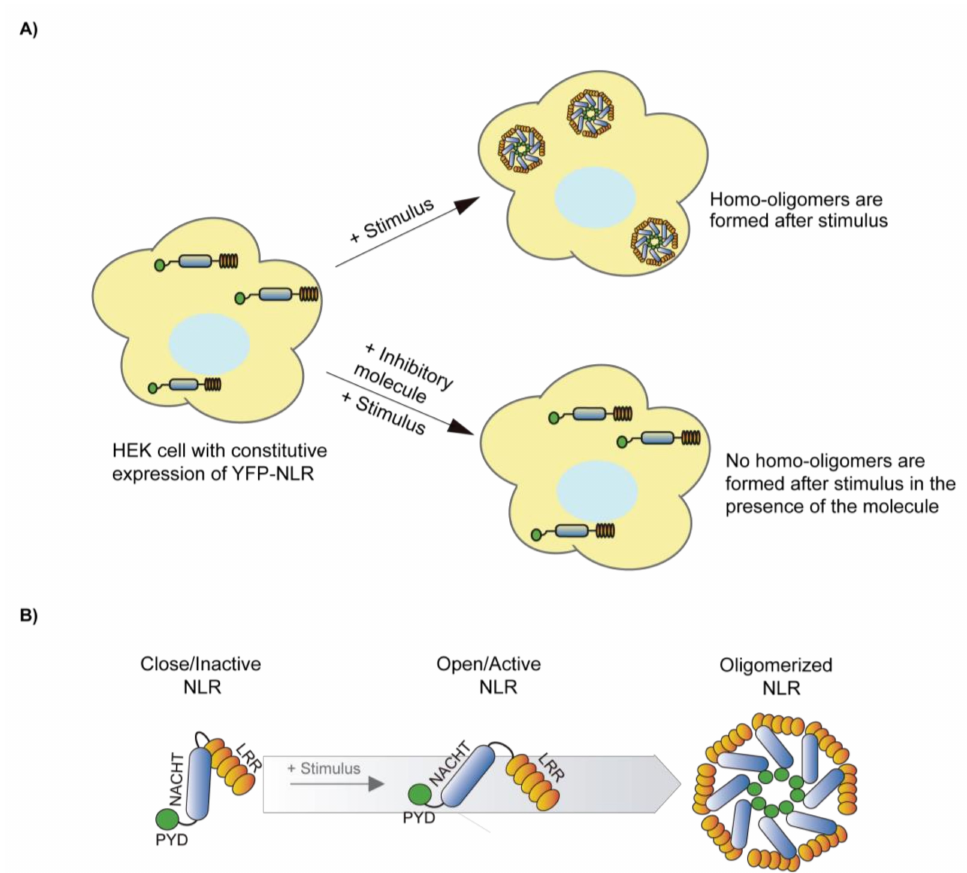
Figure 3. Schematic illustration showing the formation and the inhibition of NLR oligomers. ( A ) Illustration of NLR homo-oligomers formation after a stimulus treatment and the inhibition of homo-oligomers formation in the presence of an inhibitor. If the NLR sensor is fused to a fluorescent reporter protein, the formation of homo-oligomers appears as a puncta across the cytoplasm of the cell. If the cell treatment directly activates the NLR inflammasome, this technique is a reliable screening method to identify specific inflammasome inhibitors. If the signaling leading to inflammasome activation requires different steps, positive compounds could either directly block the inflammasome, or any of these steps. ( B ) Diagram of possible conformational changes of a closed/inactive NLR to an open/active NLR that favor the formation of